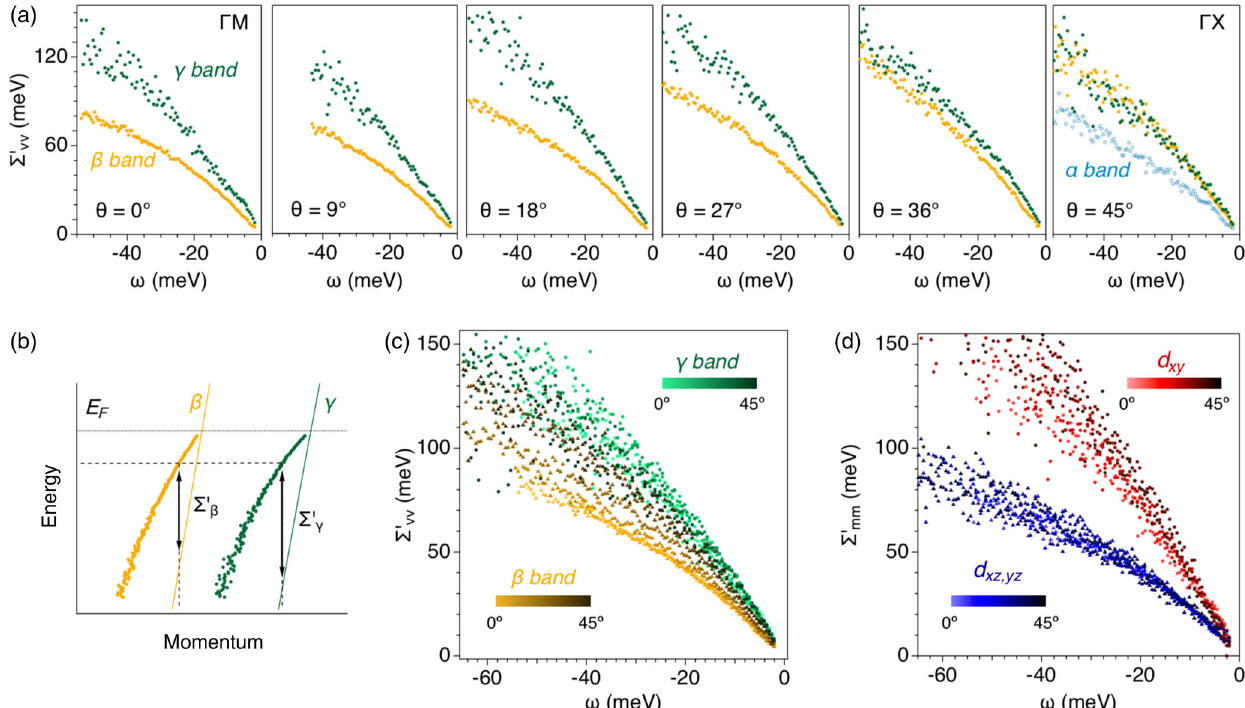
FIG. 4. Self-energies extracted in the band and orbital bases. (a) Real part of the self-energy Σ 0 νν in the band basis (solid symbols) in 9° steps of the Fermi surface angle θ . (b) Illustration of the relation between Σ 0 νν , the bare bands given by lines), and the quasiparticle peak positions (solid symbols). (c) Compilation of Σ 0 νν from panel (a). (d) Real part of the self-energy Σ 0 in the orbital mm